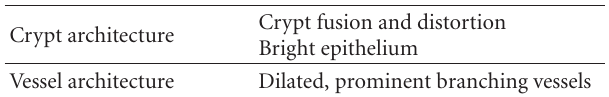
Table 3: Assessment of crypt architecture and vessel architecture by p-CLE in ulcerative colitis